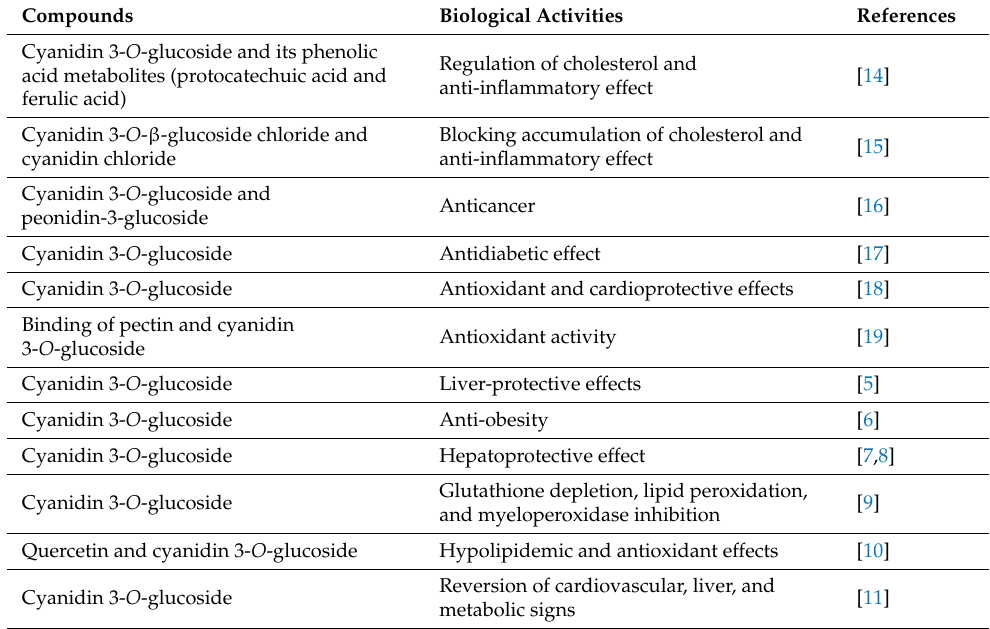
Table 1. Heath benefits of cyanidin 3- O